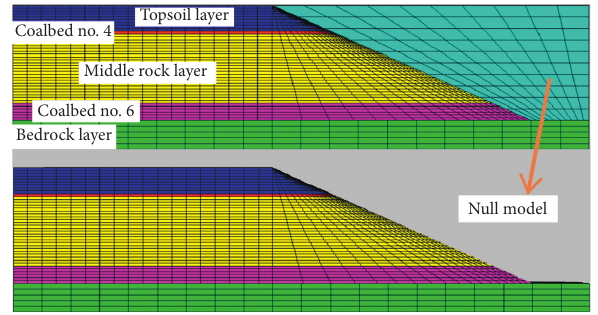
Figure 4: Numerical model of the slope after mining on the southern side of the